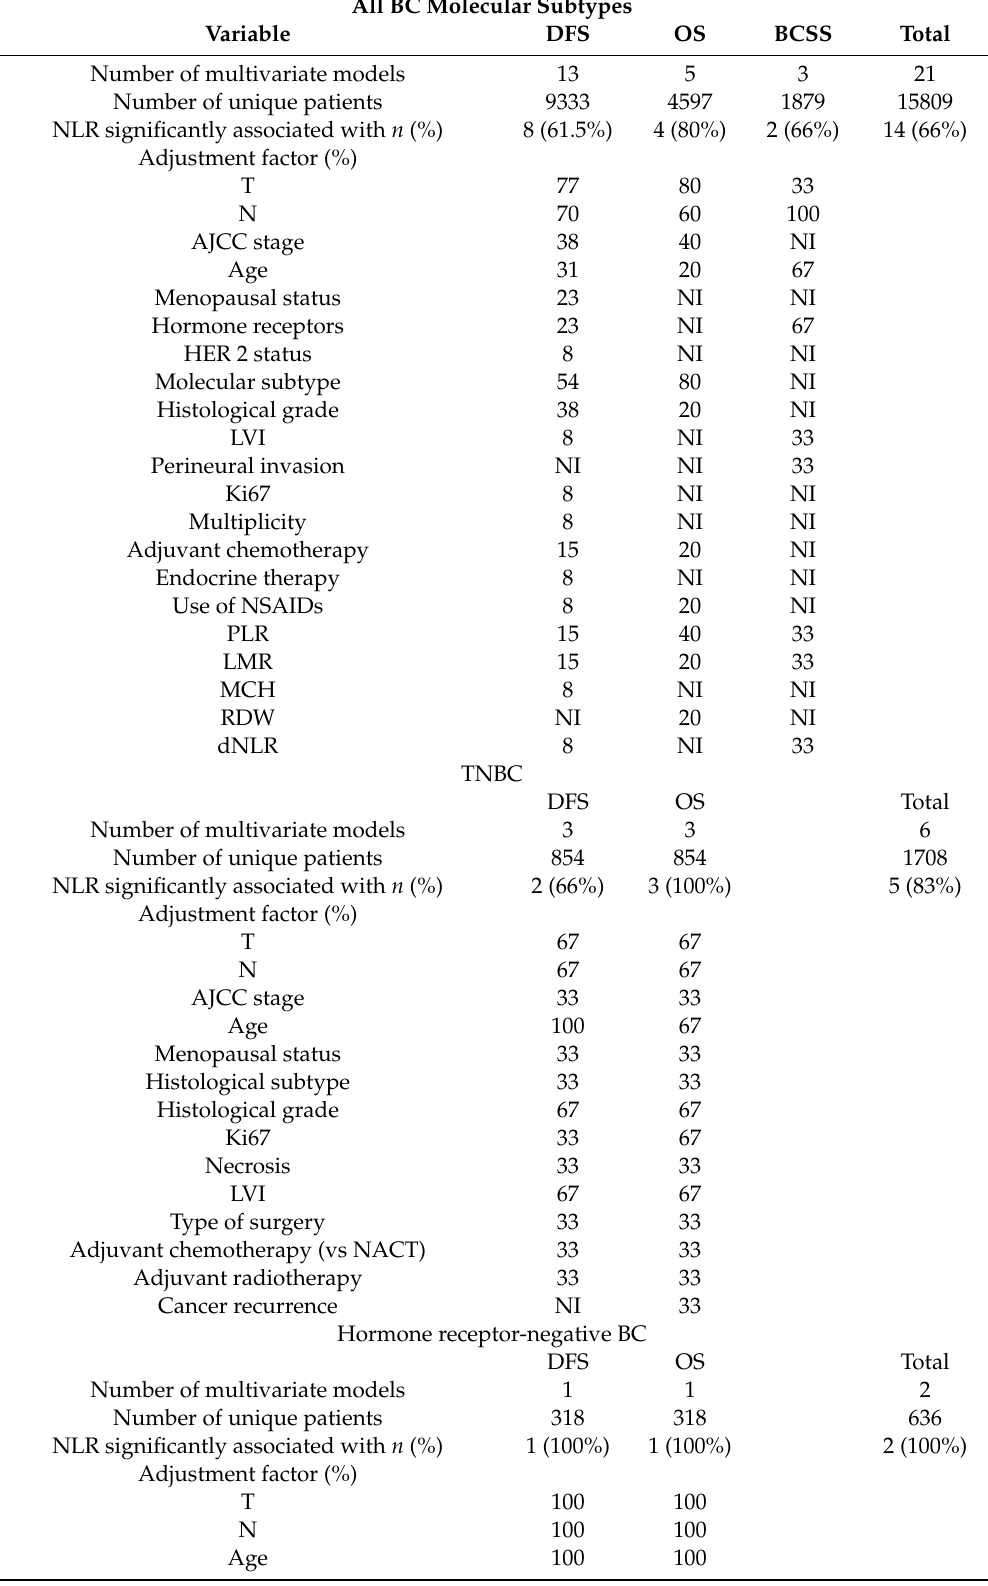
Table 4. Multivariate models (results and adjustment factors) for patients with localized BC receiving adjuvant